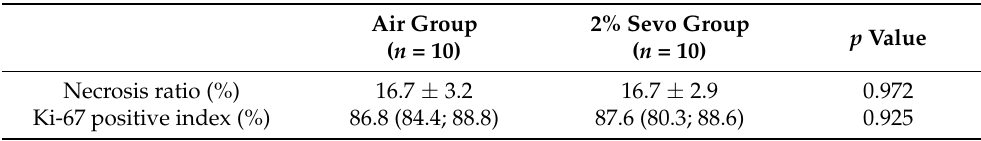
Table 2. Comparison of necrosis ratio and Ki-67 positive index of tumor tissues between Air group and 2% Sevo